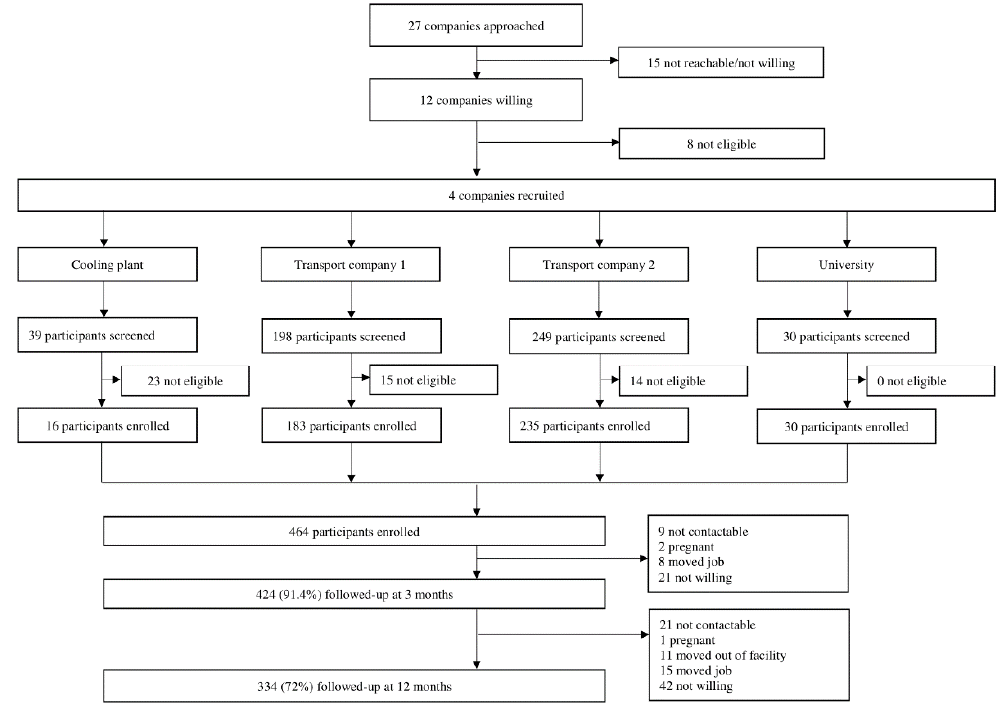
Figure 1. Participant enrolment and follow-up flowchart.